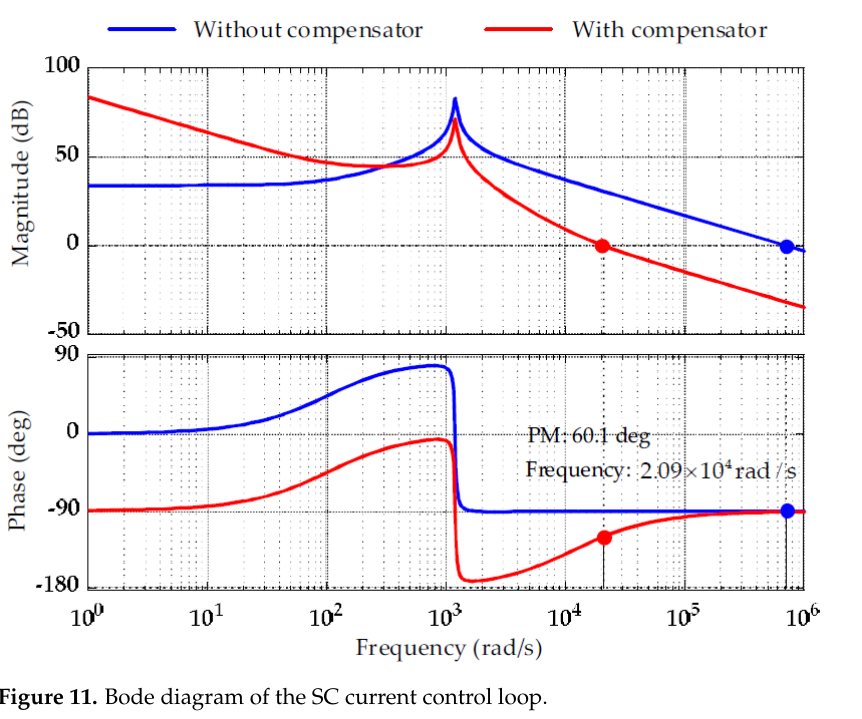
Figure 11. Bode diagram of the SC current control loop. Table 5. Parameters of the SC converter.